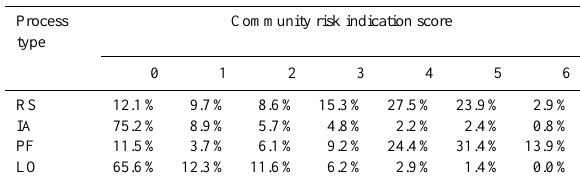
Table 12. Per cent of communities assigned to each class of the community risk indication score. Abbreviations as in Table